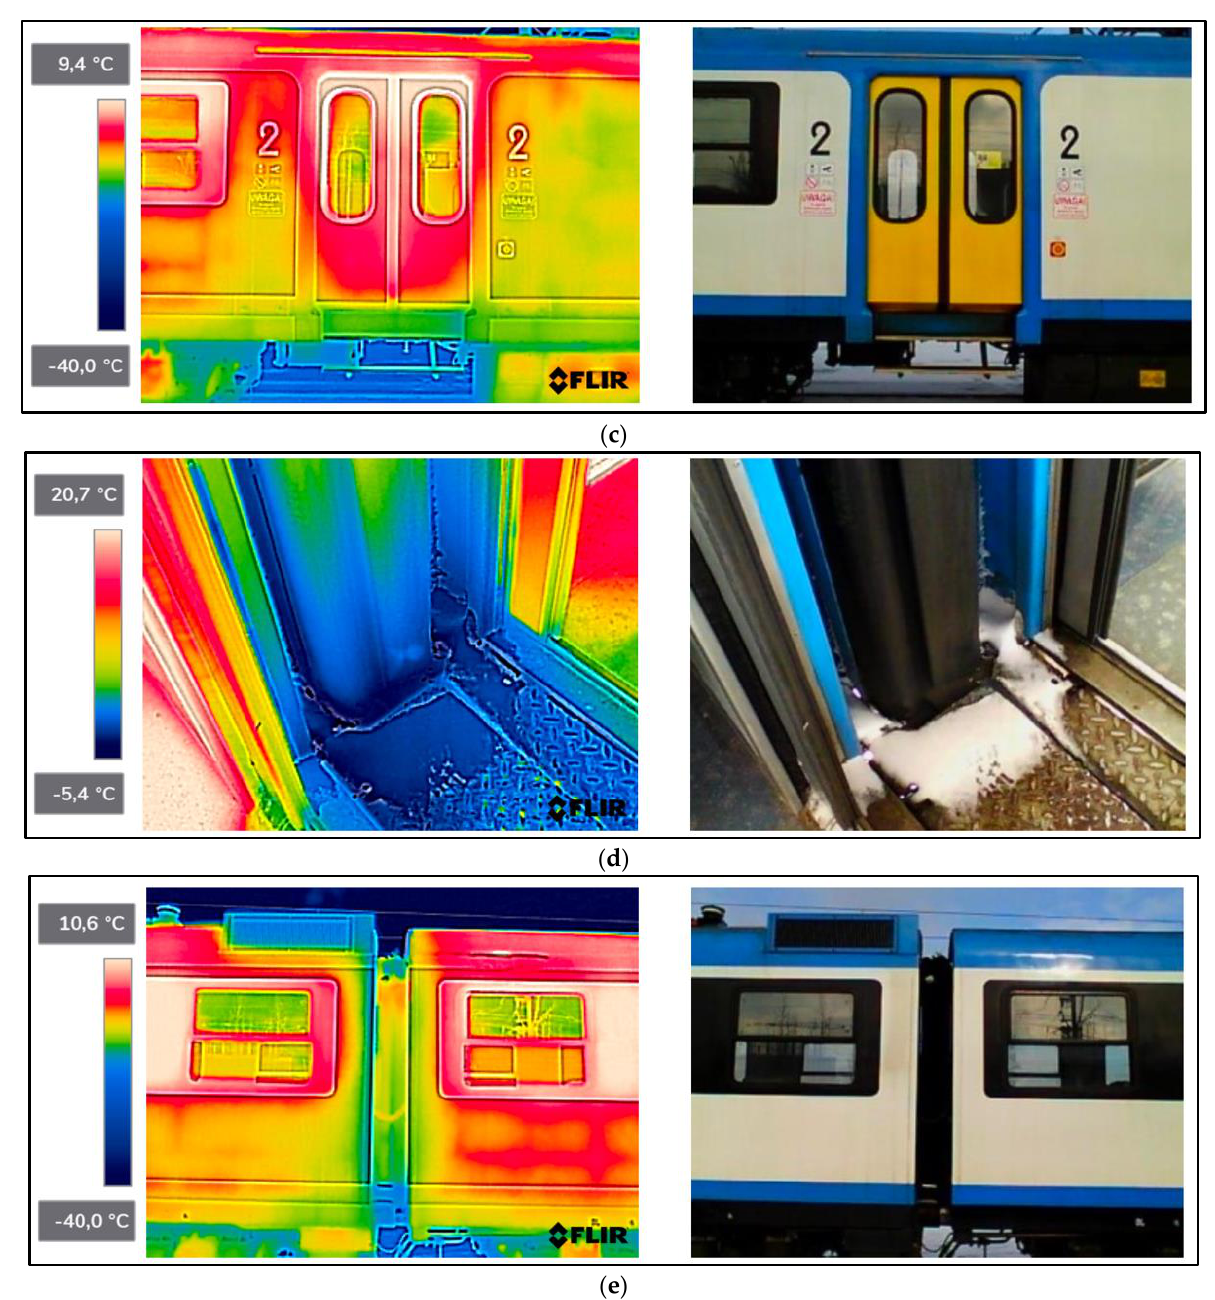
Figure 6. EN57AKŚ -223 − thermogram of critical components of the railway vehicle: ( a ) door − upper part from inside the vehicle; ( b ) door − lower part from inside the vehicle; ( c ) door from outside the vehicle; ( d ) interconnection from inside the vehicle; ( e ) interconnection from outside the vehicle.